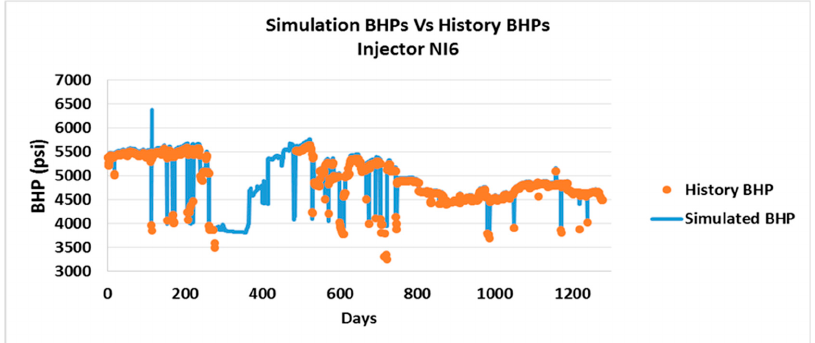
Figure 37. Simulated and historical matched BHPs for Well NI6. Figure 36. Simulated and historical matched BHPs for Well NI6. Energies 2020 , 13 , x FOR PEER REVIEW